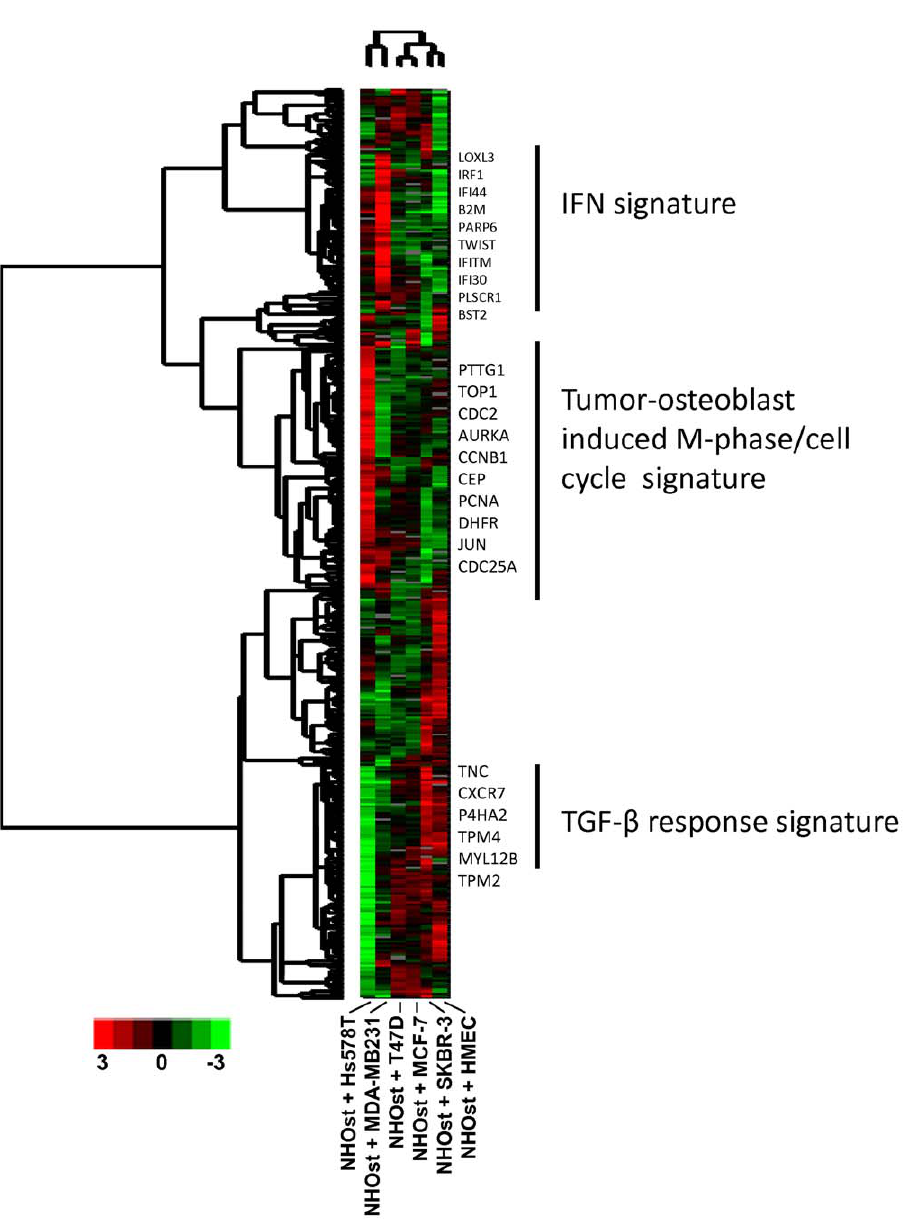
Figure 2. Gene expression changes in multiple co-cultures of breast cancer cell lines with osteoblasts. Overview of collapsed data from repeat co-culture experiments of six benign and malignant epithelial cell lines with NHOst cells. In a gene expression profiling experiment 7 monocultures and 6 co-cultures with NHOst were analyzed independently in duplicates. Genes with missing data in more than 20% of the arrays were removed, leaving 10774 gene IDs. Based on this dataset, the calculation of the interaction factors were performed separately for all co-cultures, as described in the Methods section. The interaction factors of the 6 co-cultures were further analyzed for their distribution, and factors with a standard deviation of , 2 in at least two co-cultures were eliminated, leaving interaction factors for 635 genes, which are shown as a heat map (unsupervised hierarchical clustering). Red and green denote induction and repression due toheterotypic interaction. The magnitude of induction or repression is represented by color intensity. Specific clusters involved in IFN signaling, a ‘‘tumor-osteoblast cell-induced M phase/cell cycle’’ signature and response to TGF- b are marked. doi:10.1371/journal.pone.0029743.g002 the second gene set, which did not display much overlap with the interferon ( Figure 3A ), such as the genes OAS1, IFITM1, IFITM2, interferon response factor 9 (IRF9), b -2 microglobulin first set, (2 genes only; MT-TK, SERPINE1, Figure S3 ), there (B2M) and STAT1, which is the principal transcriptional regulator of the interferon response genes. In the monocultures, the expression of this gene set was higher in NHOst cells than in MDA-MB-231 cells. These genes were used to formulate a list of ‘‘interferon response genes regulated by STAT1’’ ( Table S1 ). In beta type 8 (large multifunctional peptidase 7), and proteasome